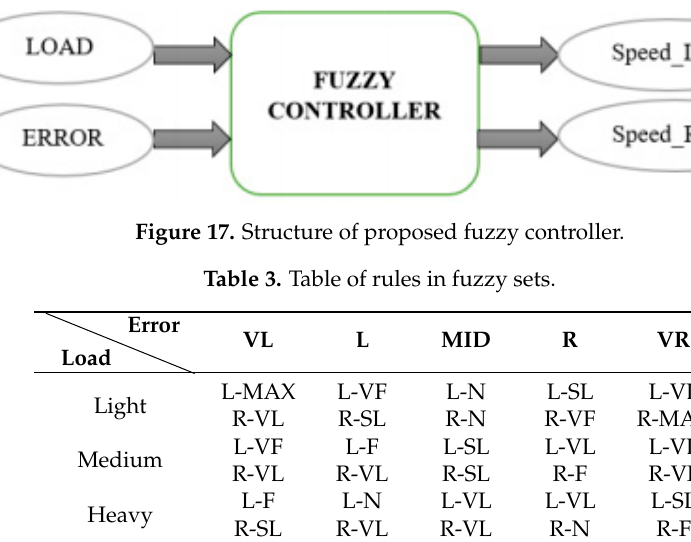
Figure 16. Design of attaching mechanism for load cell ( a ) and loading actuator ( b ).